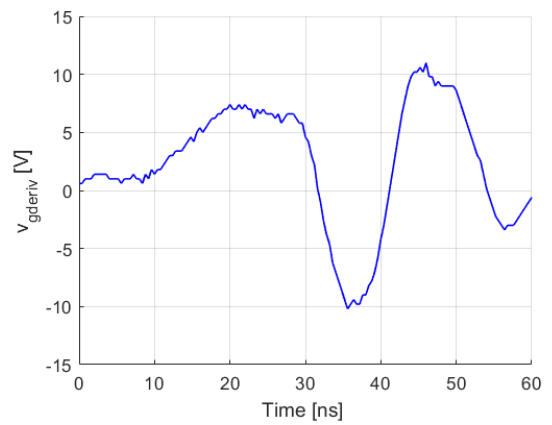
Figure 20. Experimental waveforms of the AGVC closed-loop voltage control compared to the standard gate voltage control (I d = 5 A, V_ DC = 50 V), ( a ) V gs , ( b ) V ds and I d .